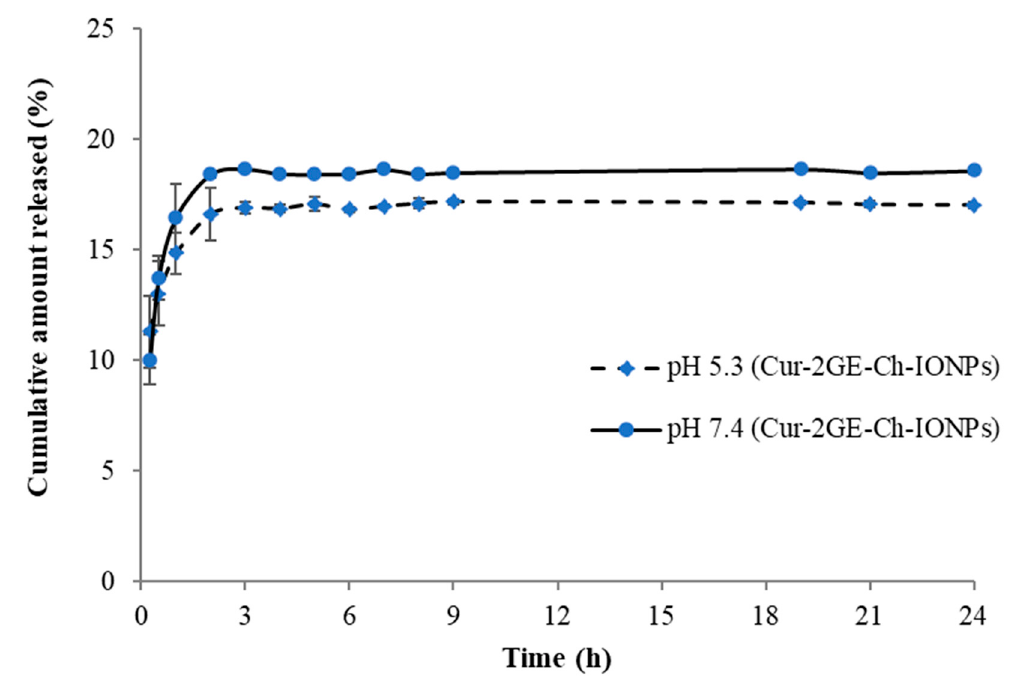
Figure 10. Release profiles of CUR-2GE from the CUR-2GE-Ch-IONPs at pH 5.3 (intratumoral pH) and pH 7.4 (blood pH).